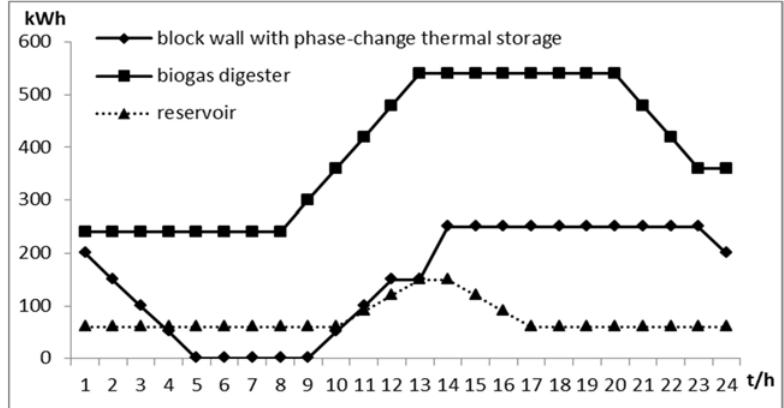
Figure 6. The stored energy curve of energy stores on a winter sunny day.